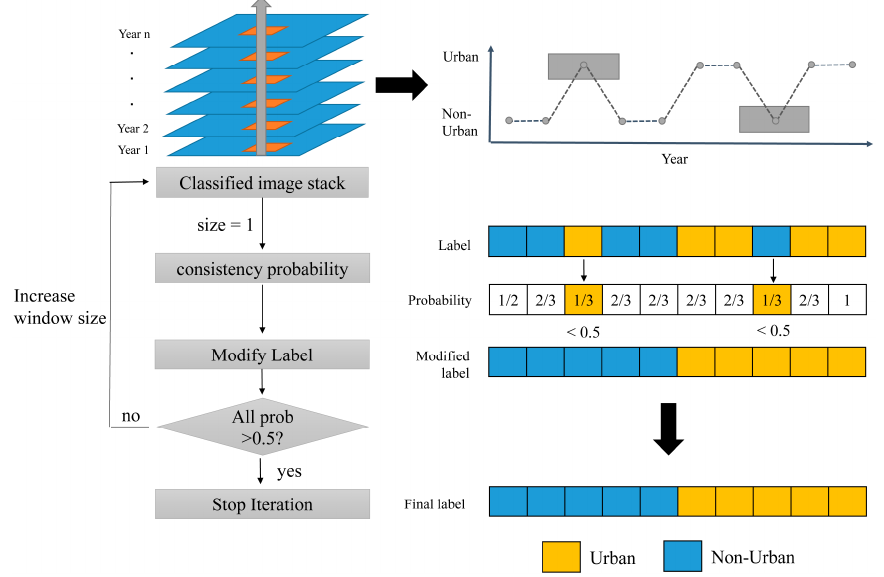
Figure 3. Process of temporal filtering. The left figure shows a standard workflow diagram of temporal filtering. The process starts with a stack of classified images and a temporal window size of one. Probability of urban occurrence was calculated for each year. After adjusting the potential misclassified labels, the iteration will stop when probabilities for all years are larger than 0.5. The right diagram uses one simple example to illustrate how the workflow works. The gray boxes in the extracted spectral curves from image stack indicate the potentially misclassified